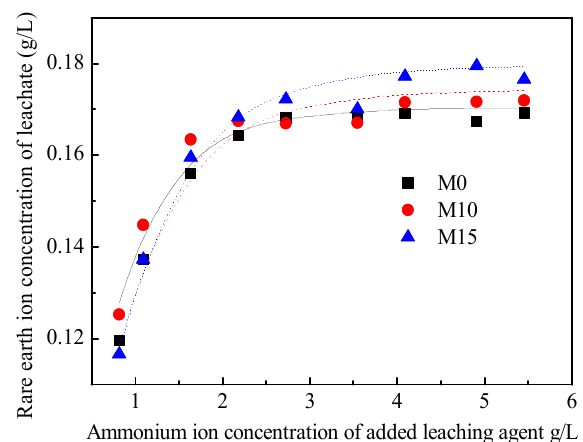
Figure 6. Results of the ion exchange equilibrium experiment.